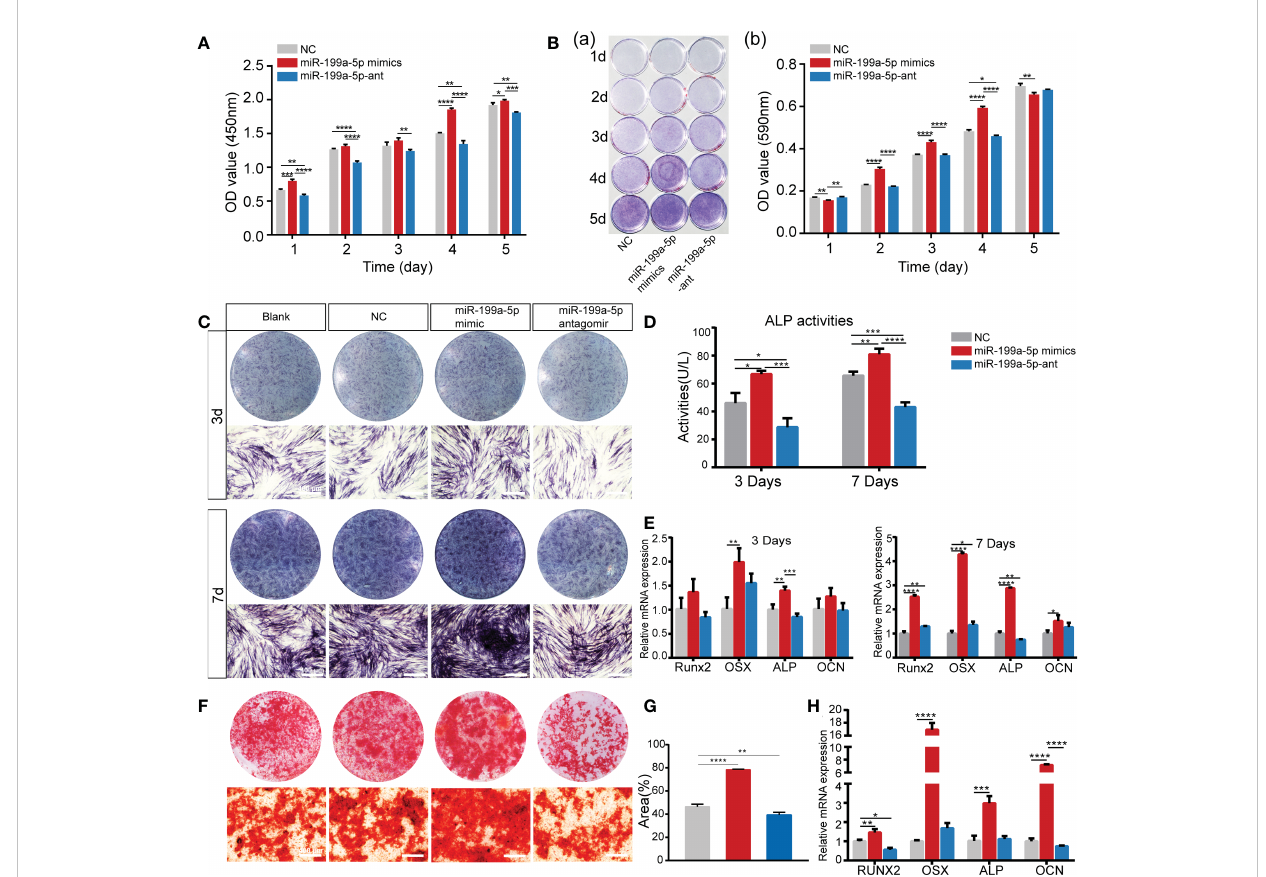
FIGURE 3 miR-199a-5p positively regulates the proliferation and osteogenic differentiation of hSCAPs in vitro . (A) The CCK8 assay. (B) The Crystal violet staining and quanti fi cation assay. (C) ALP staining of different groups after 3 and 7 days of osteogenic induction (scale bar = 400 m m). (D) ALP activity assay. (E) The relative mRNA expression level of osteogenic marker genes RUNX2, OSX, ALP, and OCN. (F) ARs staining assay (scale bar = 400 m m). (G) Semi-quantitative analysis of ARs stained images. (H) The relative mRNA expression level of osteogenic marker genes RUNX2, OSX, ALP, and OCN. The data were shown as mean ± SD. * p < 0.05, ** p < 0.01, *** p < 0.001, and **** p <